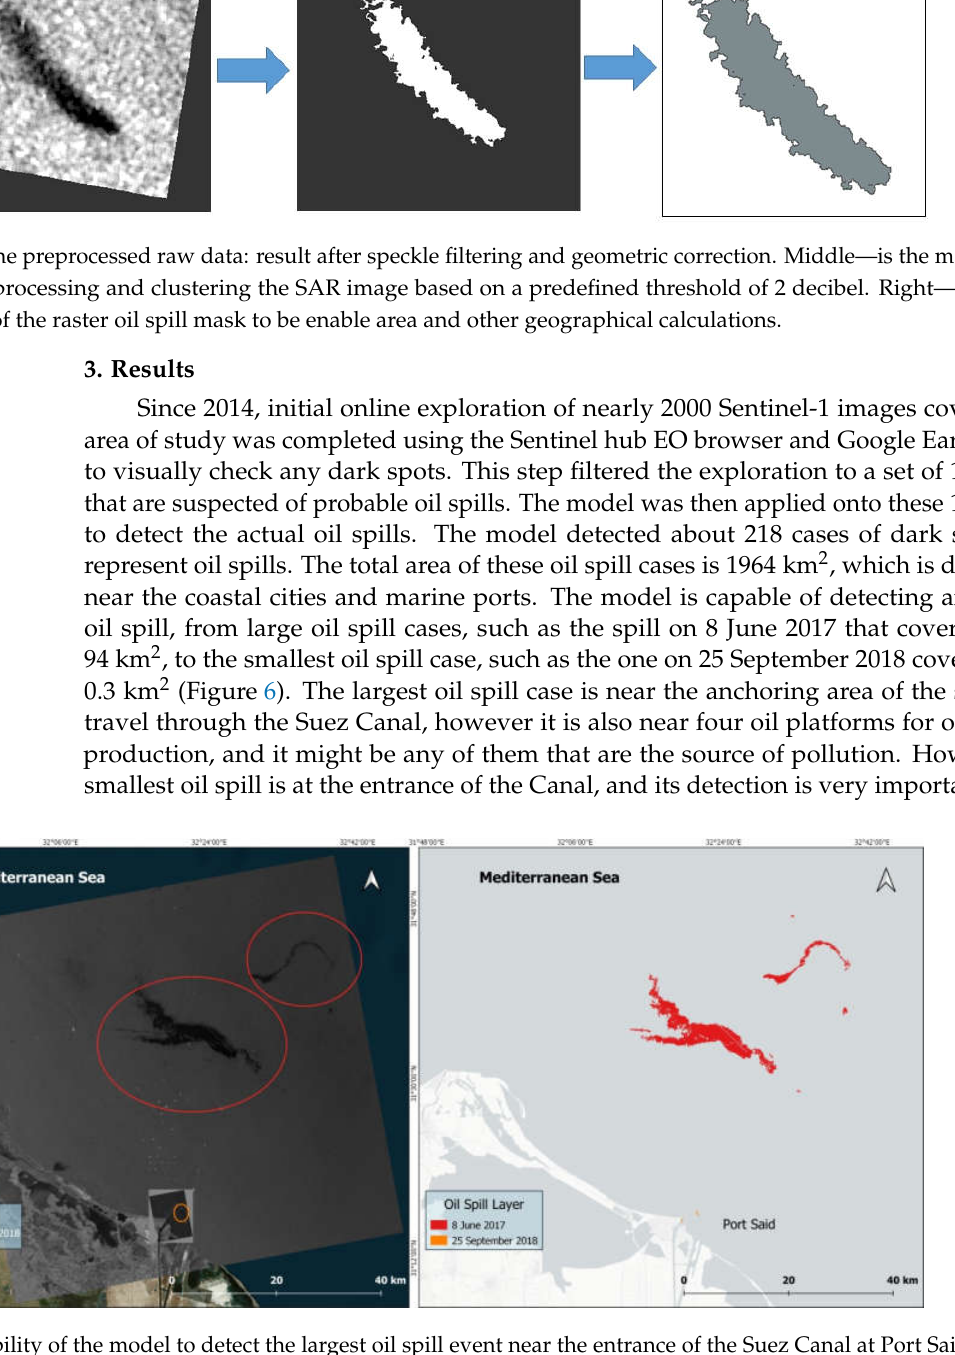
Figure 7. The capability of the model to detect the largest oil spill event near the entrance of the Suez Canal at Port Said city, which happened on 8 June 2017, with an actual mask of the oil layer with an area equals 94 km 2 and the smallest oil spill event detected, which happened on 25 September 2018, at the Canal entrance with an area of 0.3 km 2 .